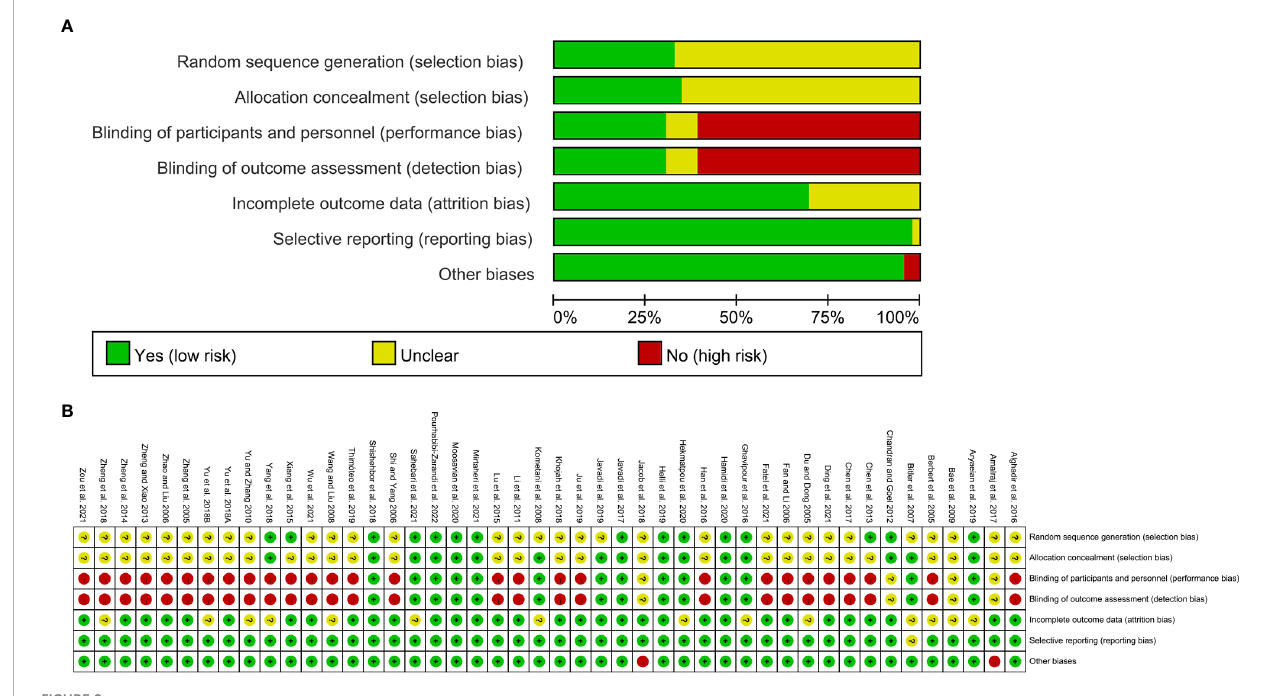
FIGURE 2 (A) risk of bias graph; (B) risk of bias